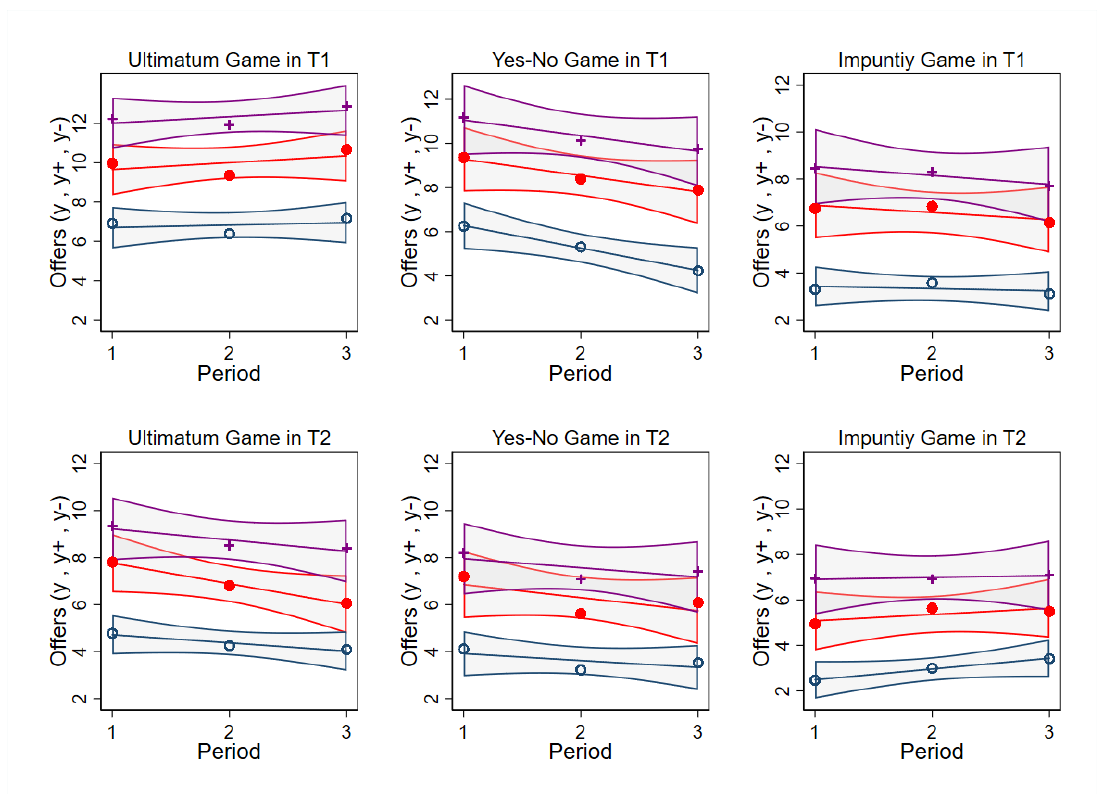
Figure A1. Independent offer and adjustments by game and treatment. Notes: Average values per period are indicated by + for y + , • for y , and ◦ for y − while lines represent linear prediction plots along with a confidence interval (CI 95%).